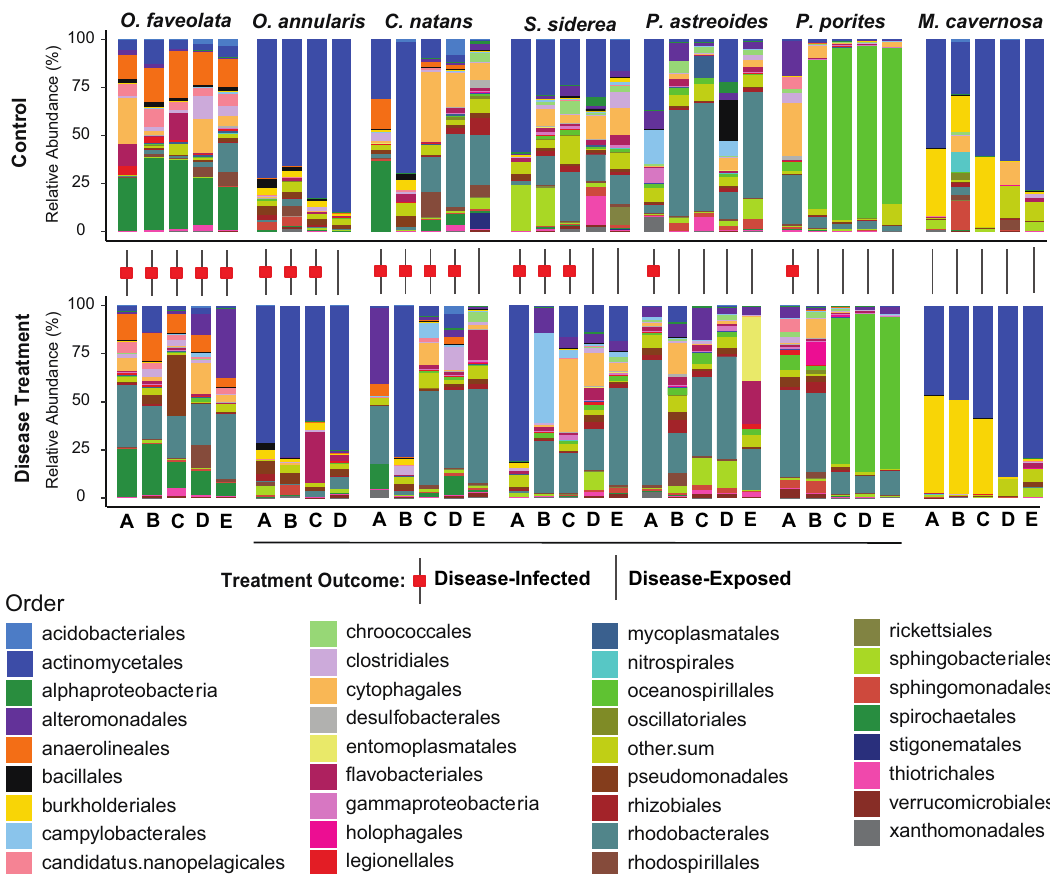
Fig. 7 Species-speci fi c bacterial community. Relative abundances of bacterial orders for each coral fragment exposed to either healthy O. franksi (i.e., control), or a white plague-infected O. franksi (i.e., disease treatment). Only bacterial orders with relative abundances greater than 3% were colored individually. All other bacterial orders were grouped into the category “ other.sum ” . Paired fragments that are genotypically identical that came from the same colony are oriented vertically to visualize how the microbiome changes from control to disease treatment exposure. The red square between vertical columns represents the genotype pair that displayed an active white plague lesion (disease-infected) by the end of the